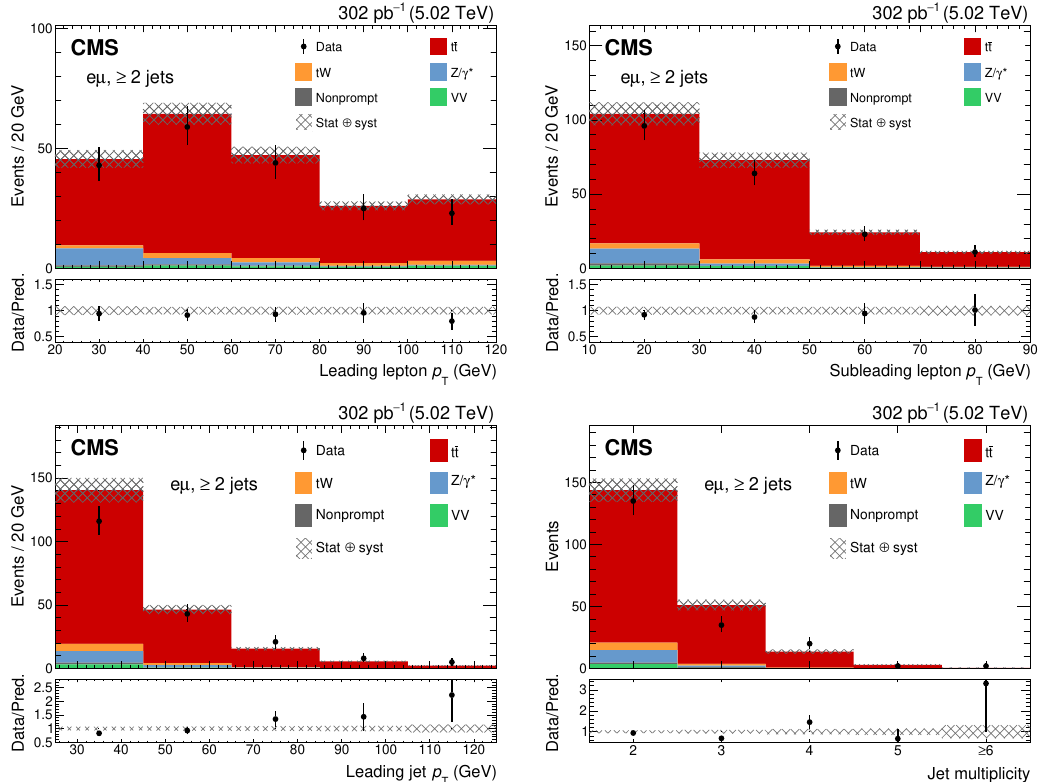
(upper left), sub-leading lepton p (upper right), leading jet p Figure 1 . Leading lepton p T T T (lower left), and jet multiplicity (lower right) in the selected events. The hatched band corresponds to systematic and statistical uncertainties summed in quadrature. The lower panels show the data-to-prediction ratio. The last bin in each distribution includes overflow